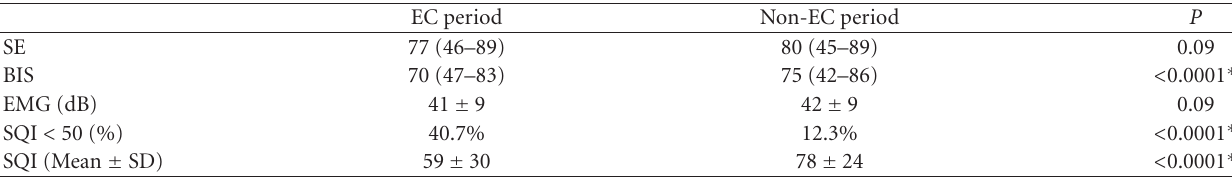
Table 2: Comparison of SE and BIS parameters during EC and non-EC